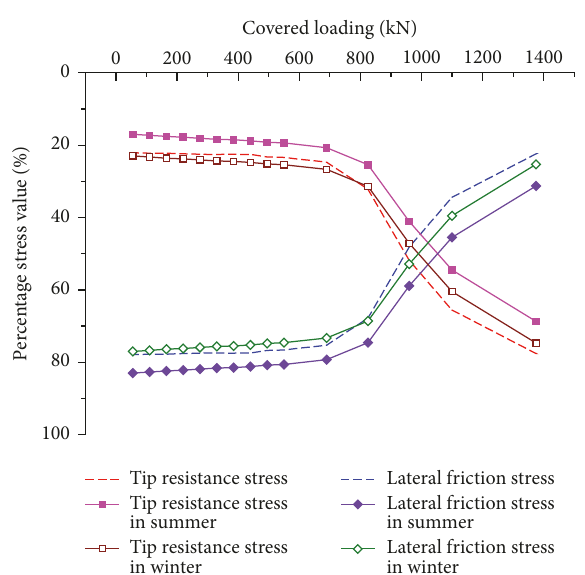
Figure 14: Percentage stress value under different covered loading in winter and